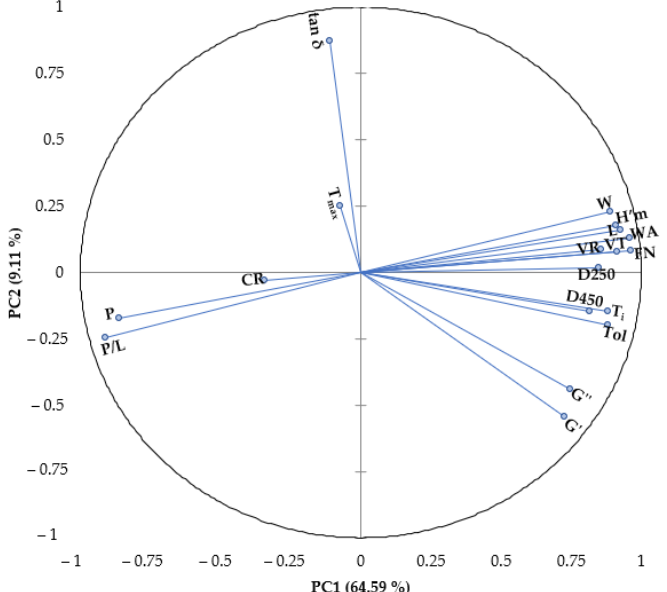
Figure 10. Principal component analysis plot of variables: FN, falling number; WA, water absorption; Tol, tolerance to kneading; D250/D450, dough consistency after 250 and 450 s, respectively; P, dough elasticity; L, dough extensibility; W, alveograph energy; P/L, alveograph curve ratio; H’m, maximum height of the gas release curve; VT, total volume of CO 2 production; VR, the volume of the gas retained in the dough at the end of the test; CR, retention coefficient; G ′ , G ″ , elastic and viscous modulus; tan δ , loss tangent; T i , initial gelatinization temperature; T max , maximum gelatinization temperature.